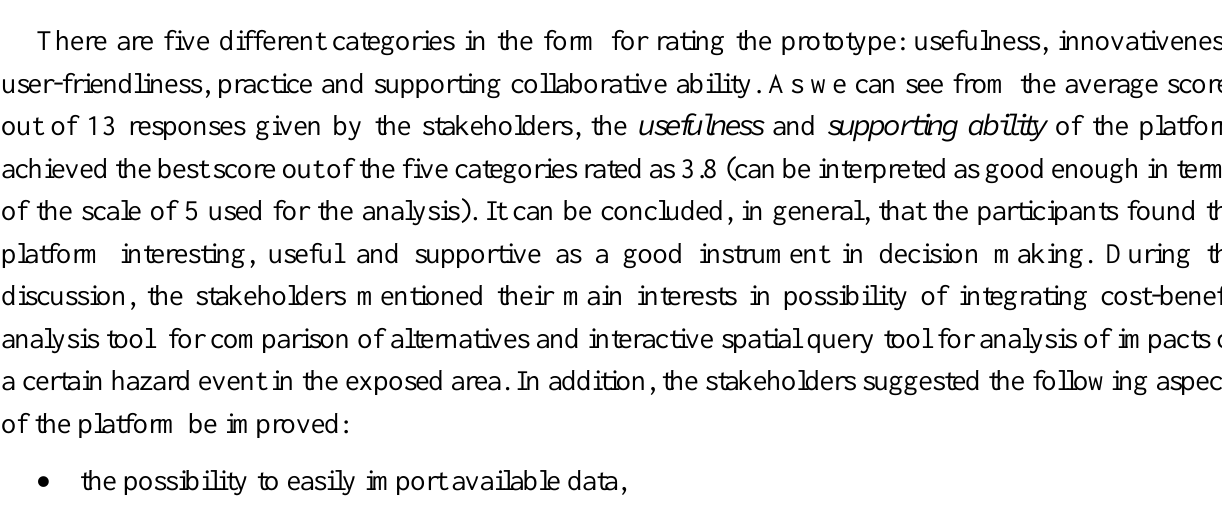
Figure 17. Quantitative feedback (Average scores out of 13